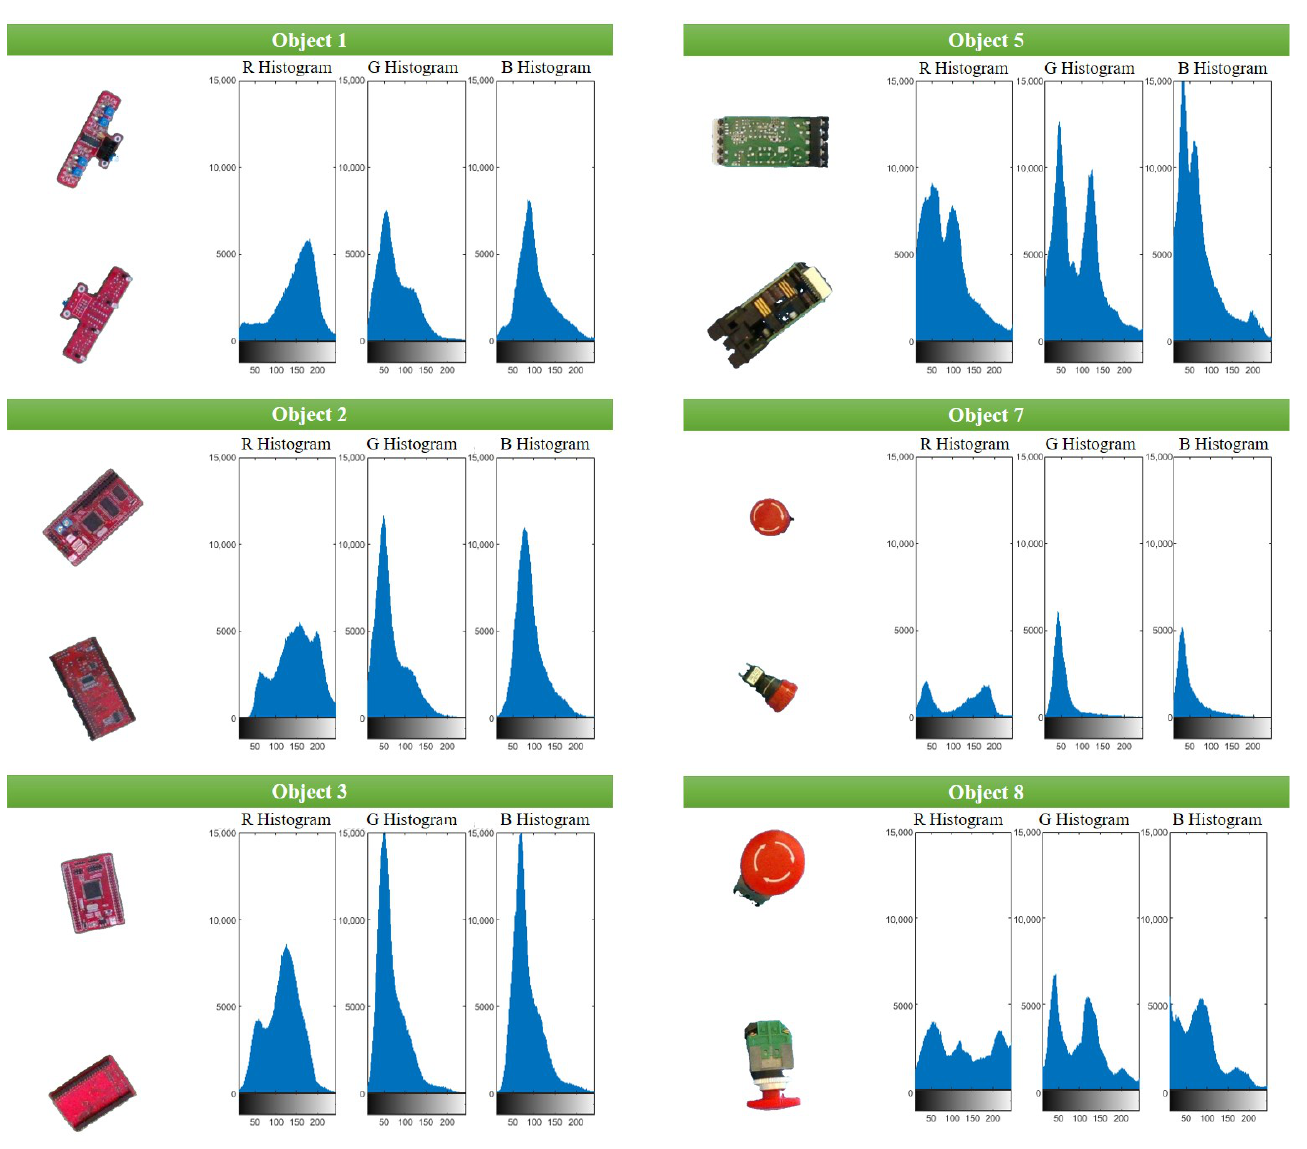
Figure 5. Partial training images and histogram of images in its category. The ideal weights for color perturbation were calculated, as depicted in Figure 6. The weight values indicated that the characteristics of the training images by histogram results were considered during the color perturbation. The summation of the weight values of each channel was three, as shown in Equation (5).